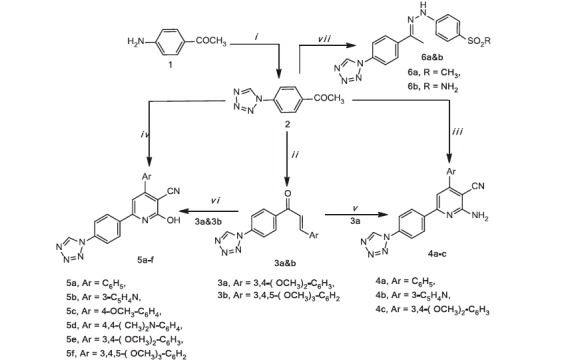
Reagent and conditions: (i) NaN3, TEOF, gl. HAc, reflux, 12 h, (ii) ArCHO, KOH, abs. EtOH, r.t., 10–12 h, (iii) ArCHO, CN(CH2)CN, NH4OAc, abs. EtOH, (iv) ArCHO, CNCH2COOEt, NH4OAc, abs. EtOH, (v) CN(CH2)CN, NH4OAc, abs. EtOH, (vi) CNCH2COOEt, NH4OAc, abs. EtOH, (vii) p-substitutedphenylhydrazine hydrochloride, abs. EtOH, reflux, 6–8 h.